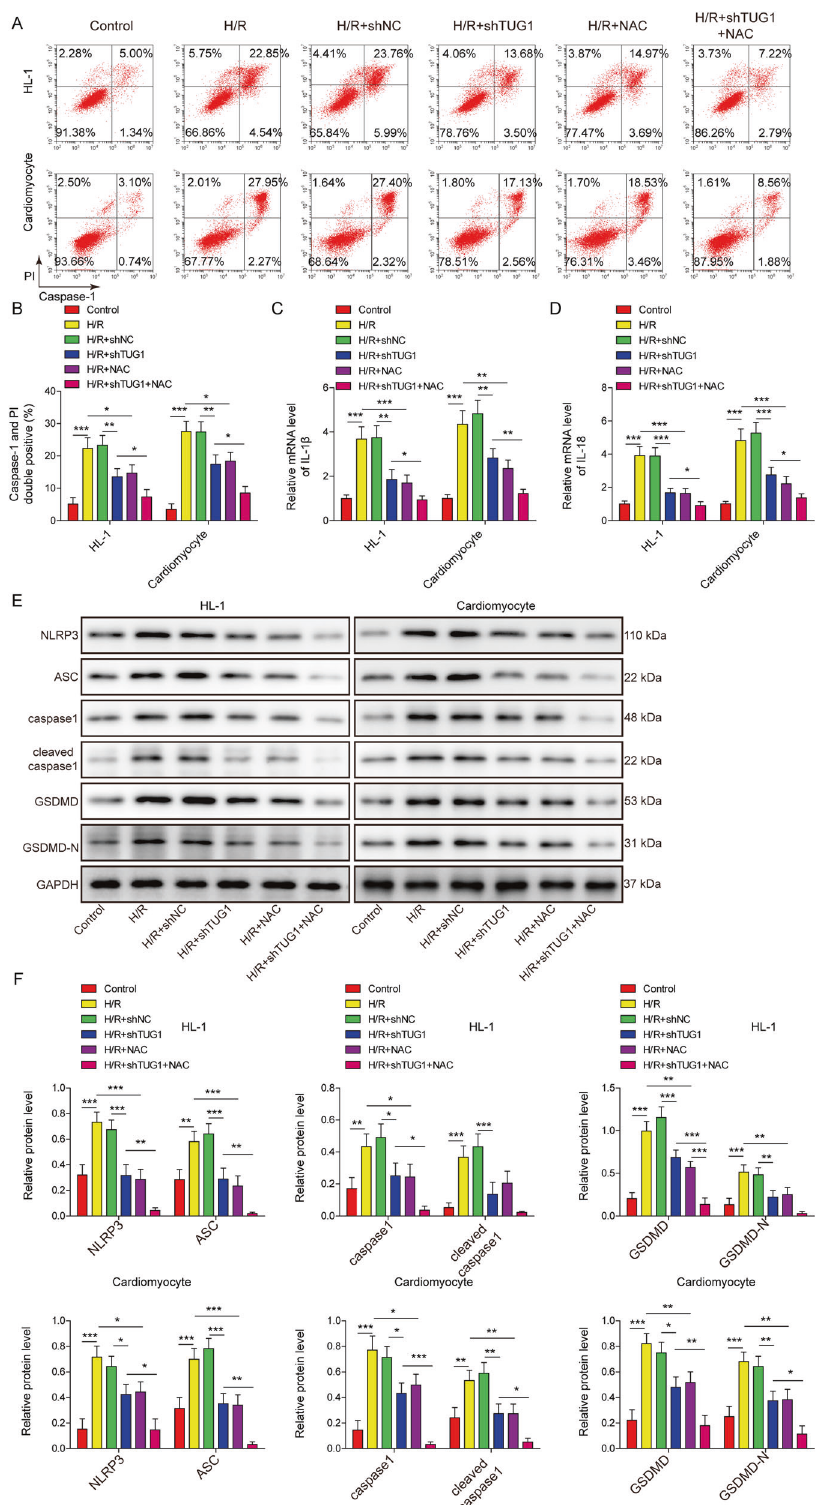
Fig. 6 Silencing TUG1 inhibited H/R-induced pyroptosis of cardiomyocytes by decreasing the generation of ROS. HL-1 and primary mouse cardiomyocytes were transfected with shTUG1 or treated with the ROS inhibitor NAC and then subjected to H/R. A , B Caspase-1 activity was measured using fl ow cytometry. C IL-1 β , and D IL-18 expression was measured using qRT-PCR. E , F The expression of NLRP3, ASC, and other downstream pyroptosis-related factors was measured using western blotting. * P < 0.05, ** P < 0.01 and *** P < 0.001.